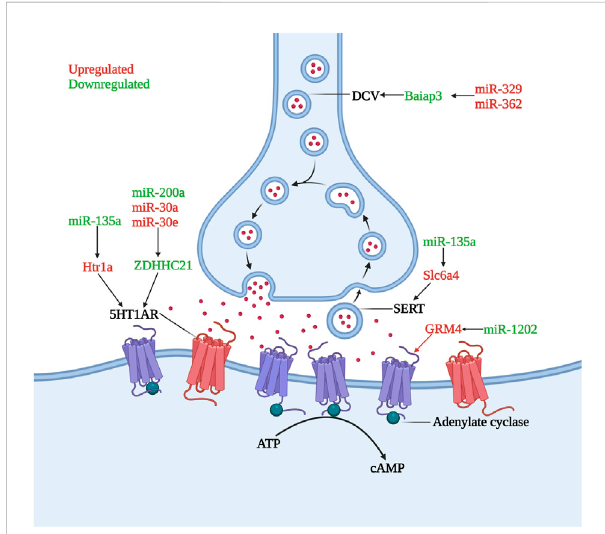
FIGURE 1 Role of microRNAs in serotonin dysregulation. The inhibitory receptor 5HT1AR is hyperactivity or increased under the in fl uence of miR-135a, miR-200a, miR-30a, and miR-30e, lead to the occurrence and development of depression. DCV and SERT undergo quantitative abnormalities under the in fl uence of miR-329, miR-362 and miR-135a, causing dysregulation of monoamine transmitter secretion and reuptake. GRM4, whose transcription is increased by miR-1202 downregulation, can regulate monoamine neurotransmitter transmission (Created with